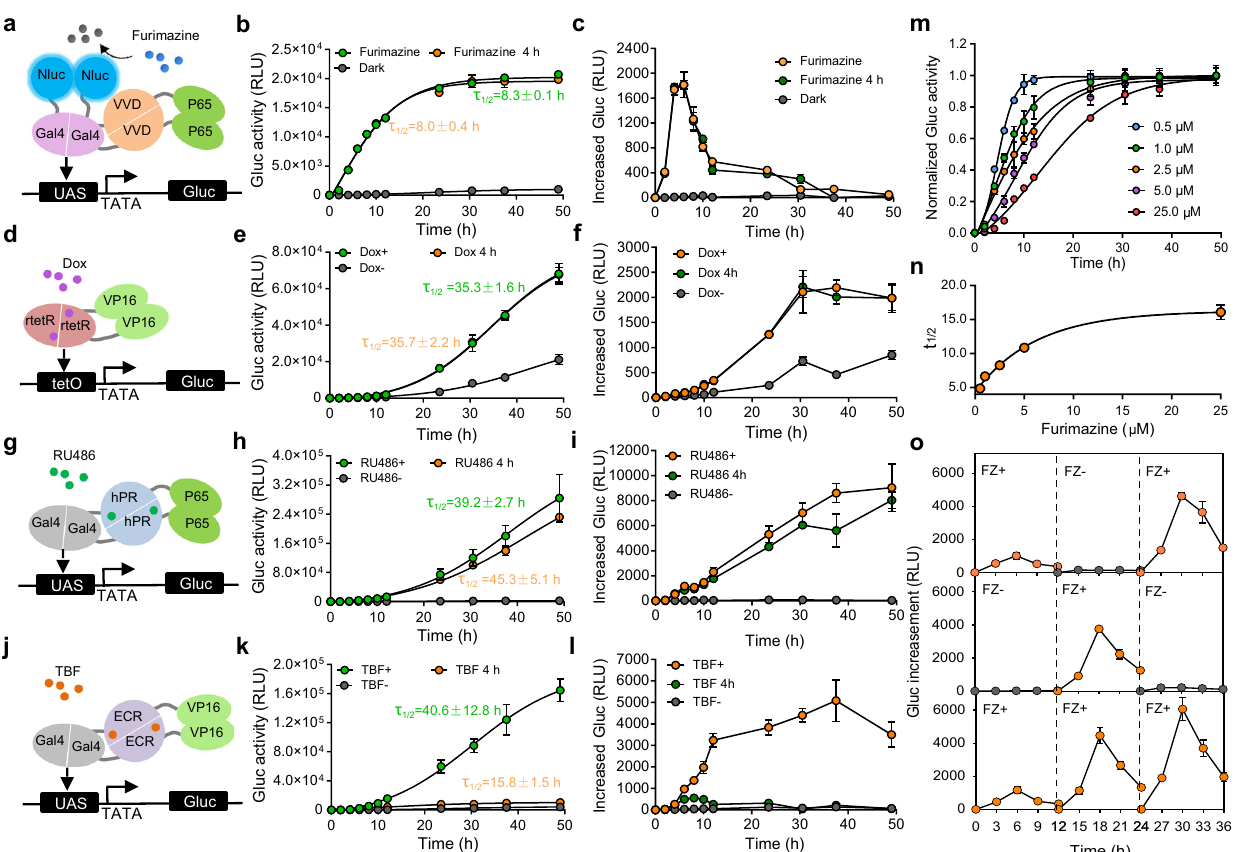
Fig. 2 Pulsatile activation of transgene expression by luminGAVPO. Time course of Gluc expression kinetics mediated by different chemical-inducible transgene expression systems induced by furimazine ( a – c ), Doxycyline (Dox) ( d – f ), Mifepristone (RU486) ( g – i ) or Tebufenozide (TBF) ( j – l ). HEK293 cells were transfected with plasmids encoding the corresponding components of different systems. The cells were induced by 2.5 μ M furimazine, 1 μ M Dox, 1 μ M TBF or 0.1 μ M RU486 for 24 h or only for 4 h. Gluc activity at the indicated time points after induction was measured, and τ 1/2 values are indicated ( b , e , h , k ). The increase in Gluc expression between a time point and the previous time point was replotted from ( b , e , h , k ) and is indicated as ( c , f , i , l ), respectively. Cells kept in the dark without induction were used as controls. m Time course of Gluc expression kinetics induced by different concentrations of furimazine. Data were normalized to the maximal Gluc expression. n τ 1/2 values of Gluc expression induced by different concentrations of furimazine. o Reversible activation of Gluc expression mediated by luminGAVPO. The transfected cells were treated with different programmed durations of furimazine induction within 36 h. The medium was refreshed every 12 h to remove the accumulated Gluc. Data represent the increase in Gluc expression between a time point and the previous time point. Data in ( b – c , e – f , h – i and k – o ) represent the mean ± s.d. from three technical replicates. Source data are provided in the Source Data fi